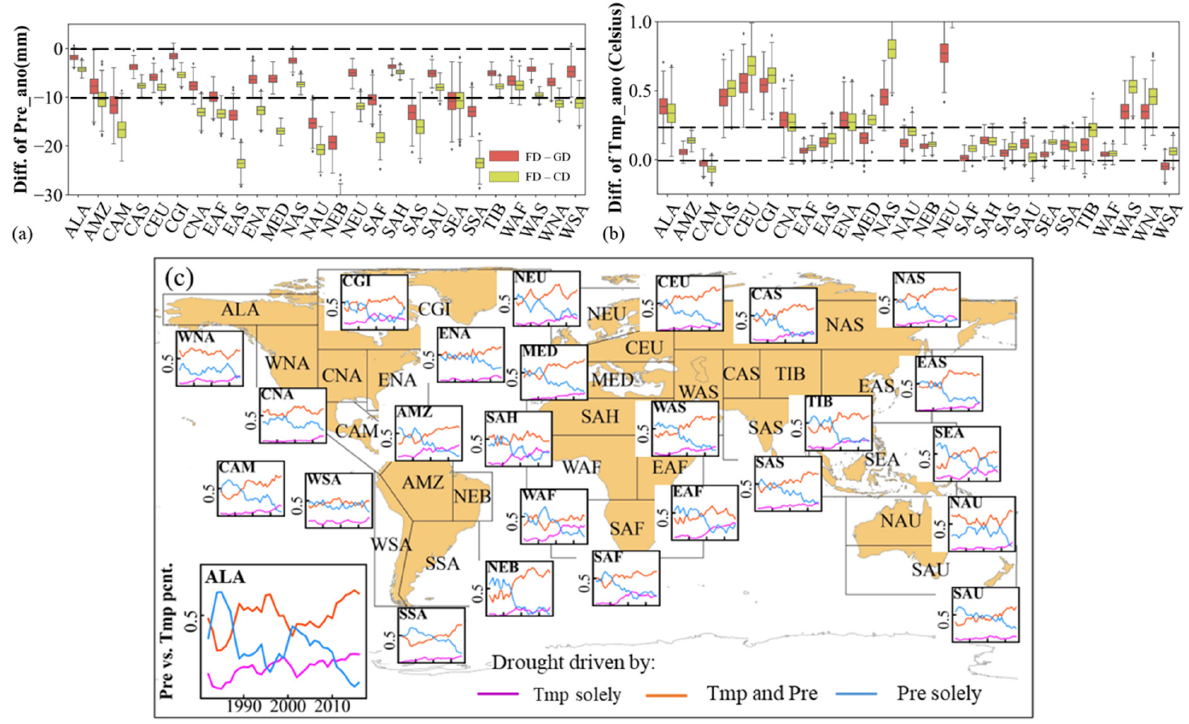
Figure 9. The difference in mean precipitation ( a ) and temperature ( b ) anomalies for the month when different droughts occurred. The red box in ( a , b ) shows the difference between flash drought and general drought while the yellow box shows that between flash drought and creep drought. ( c ) Contributions of the climatic variables associated with onset flash droughts are described as the percentage (pcnt.) of drought events per year driven by precipitation (Pre), temperature (Tmp), and both (Pre and Tmp).